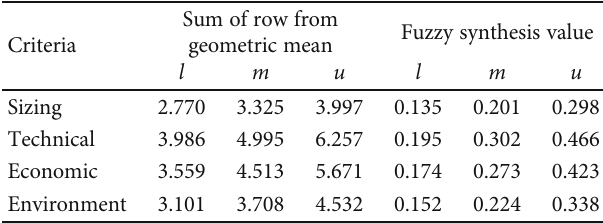
Table 10: Matrix geometric mean of fuzzy synthesis value.